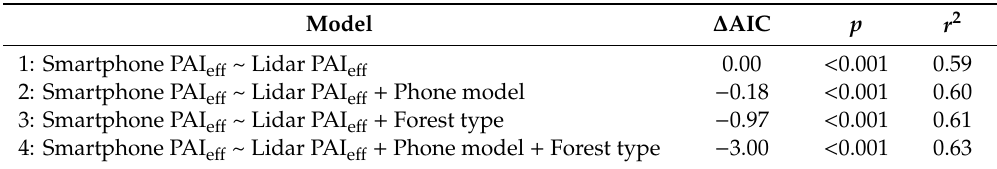
Table 3. Comparison among models to explain variation in smartphone PAI e ff . All models were fit using all 42 observations of smartphone and lidar PAI e ff at La Selva. All ∆ AIC values are relative to model 1. Values for r 2 are the adjusted r 2 values for each linear